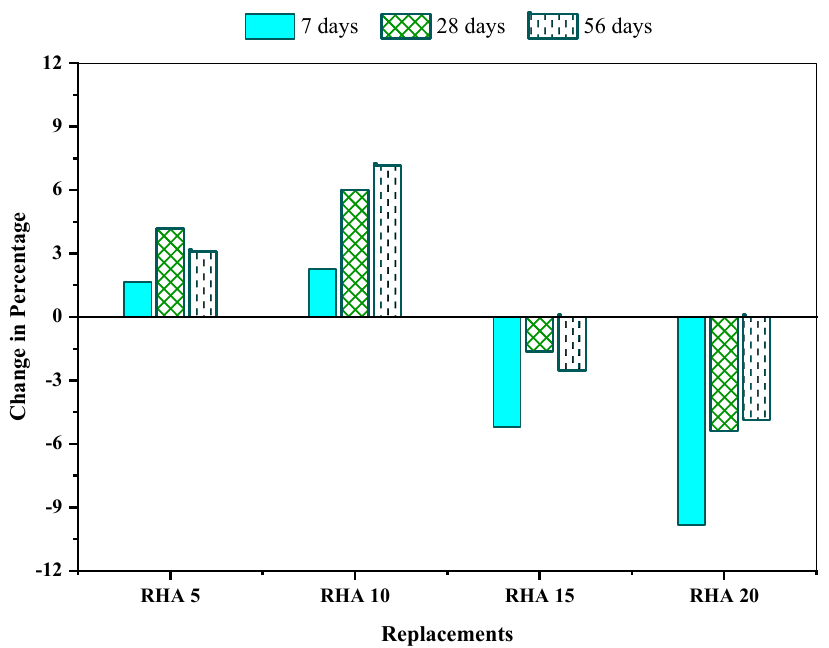
Figure 8. Compressive strength change (%) of the concrete mixes, in comparison to reference con- crete.